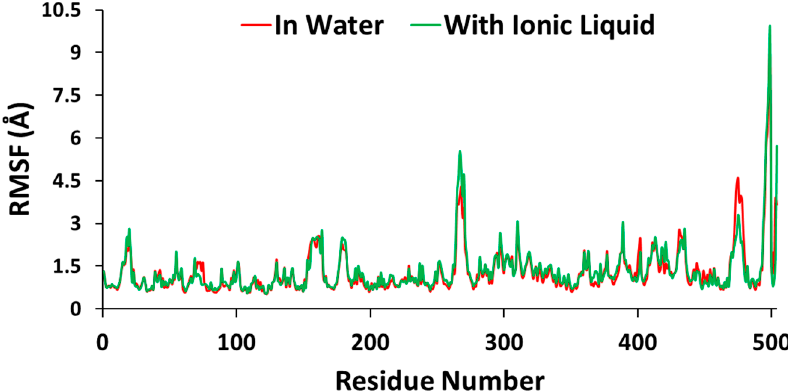
Figure 6. Average RMSF of laccase protein residues (1 to 504) from three 1000 ns trajectories in water (red) and in water with TMG-Ser (green).